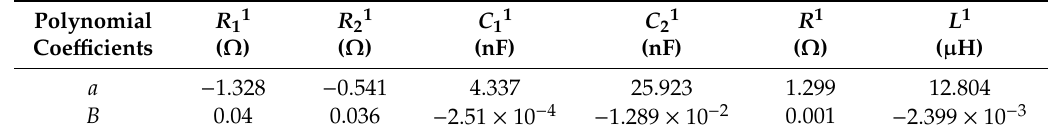
Table 8. Linear parameters for MT5 pi-circuit as a function of soil resistivity.